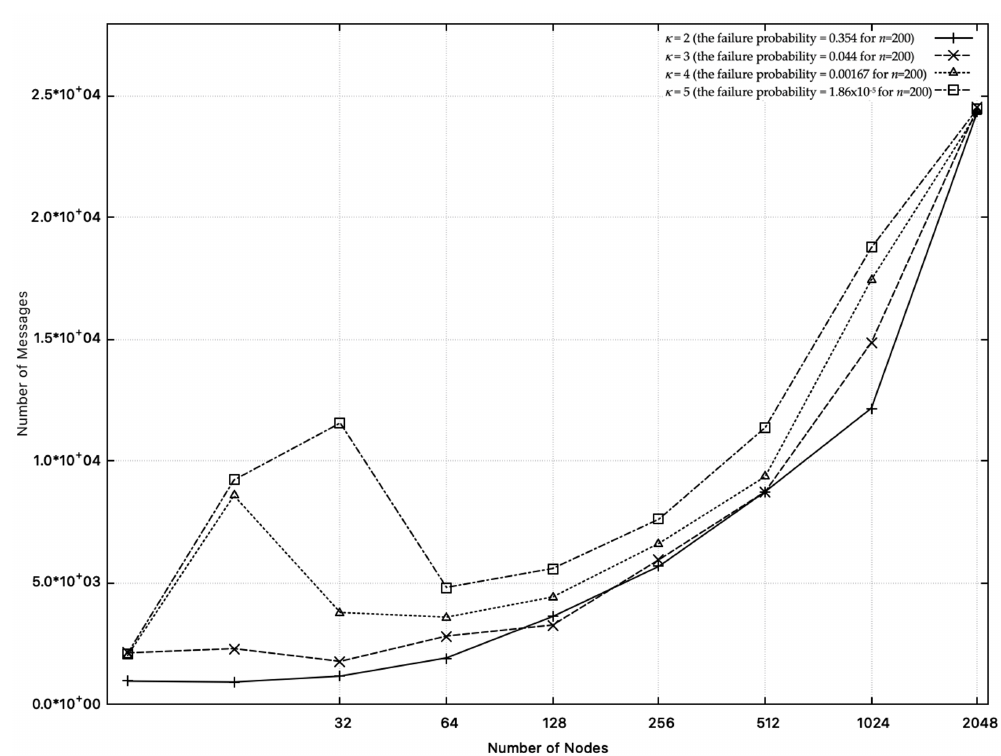
Figure 16. Message complexity over different κ values in DDR-coin: n = 2 3 ∼ 2 11 , w =